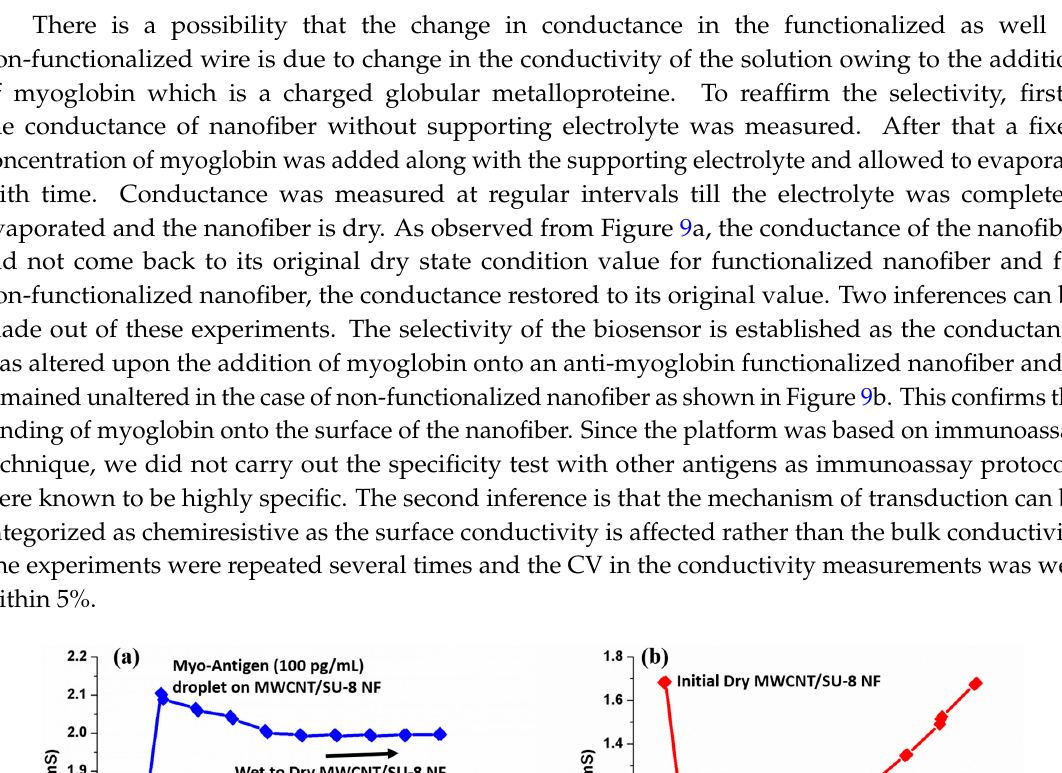
Figure 8. Detection of myoglobin on single functionalized MWCNT/SU-8 nanofiber (a: 6 fg/mL; b: 10 fg/mL; c: 100 fg/mL; d: 10 pg/mL; e: 100 pg/mL; f: 10 ng/mL; g: 100 ng/mL; and h: 10 ug/mL); Variation in the case of non-functionalized nanofiber is random.